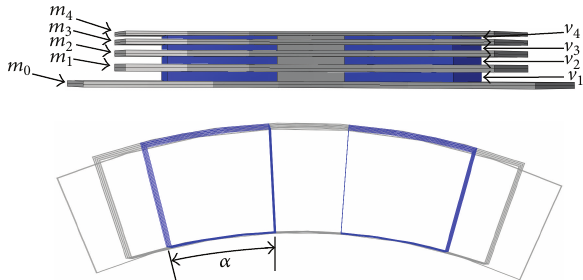
Figure 1: Designing parameters of a sandwich-type